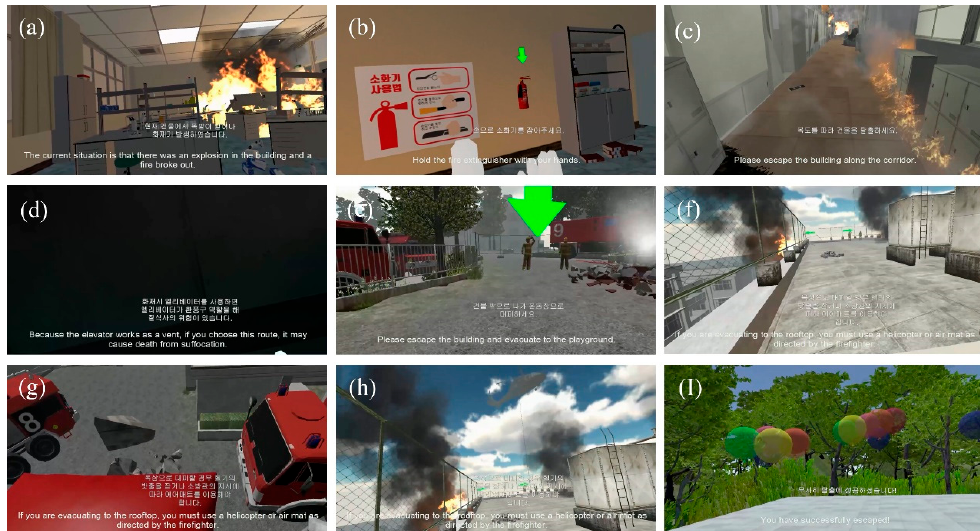
Figure 1. In-game images: ( a ) laboratory fire; ( b ) how to use a fire extinguisher; ( c ) escaping a fire; ( d ) escaping through an elevator (not to be used as it can lead to the death of the player and returning to stage C); ( e ) escaping to the ground; ( f ) rooftop evacuation; ( g ) using an air mattress; ( h ) escaping with a rescue helicopter; ( i ) summarization of what was learned [10]. Copyright © 2020, Springer-Verlag London Ltd.